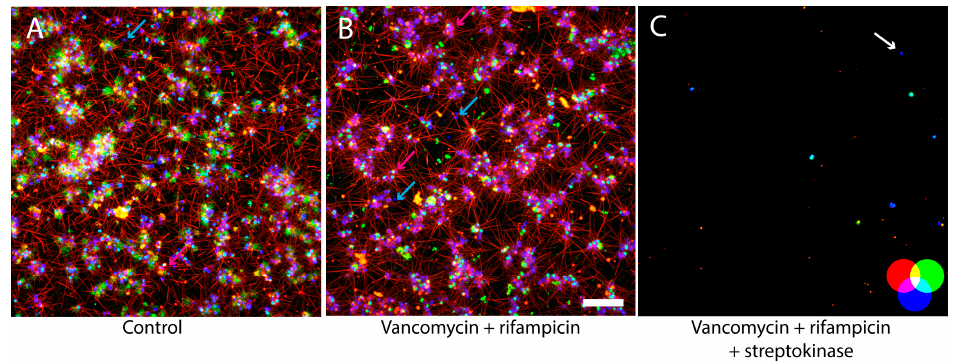
Figure 3. Confocal Laser Scanning Microscopy (CLSM) imaging of USA300 biofilms grown in BHI with plasma and Alexa Fluor conjugated fibrinogen. After 24 h growth, biofilms were incubated for 24 h in media ( A ), or media amended with vancomycin (4 mg/L) and rifampicin (10 mg/L) ( B ), or media amended with vancomycin (4 mg/L) and rifampicin (10 mg/L) and streptokinase (500 U/mL) ( C ). Alexa Fluor conjugated fibrinogen appear red , viable cells stained by SYTO 41 appear blue , and dead cells stained by TOTO ® -1 appear green , cyan, and yellow because some of these cells also bound fibrinogen and SYTO 41. Blue arrows indicate cells that did not appear to bind fibrinogen, and pink arrows indicate cells that bound fibrinogen and appeared to cause coagulation of fibrinogen to fibrin fibers. Combination of antibiotics with streptokinase resulted in almost complete eradication of the biofilm. A single viable cell that did not bind TOTO ® -1 is indicated by the arrow. Scale bar = 20 µ m. Table 2. MBEC against biofilms of S. aureus USA 300 grown for 24 h in tryptic soy broth (TSB) and incubated with antibiotics in the presence or absence of streptokinase. Rifampicin was added at a fixed dosage of 10